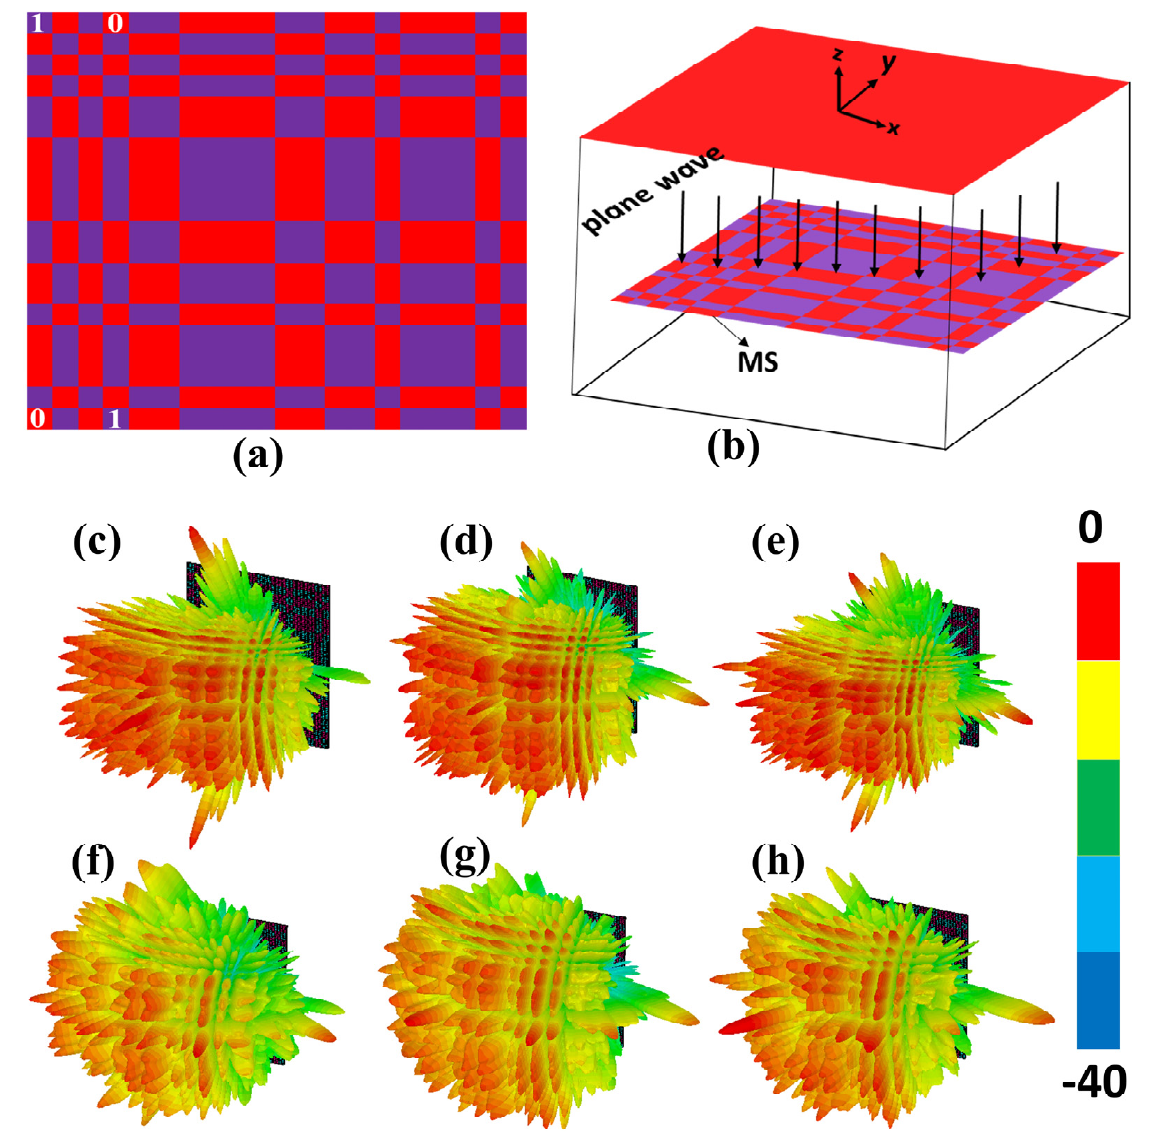
Figure 6. ( a ) Optimized coding sequence of a checkerboard MS. ( b ) Simulation setup. Normalized 3D far ‐ field scattering patterns of a proposed checkerboard MS for ( c – e ). TE incidence wave at 34, 36, and 38 GHz. For TM incidence wave at ( f ) 21.5, ( g ) 23, and ( h ) 24.5 GHz.